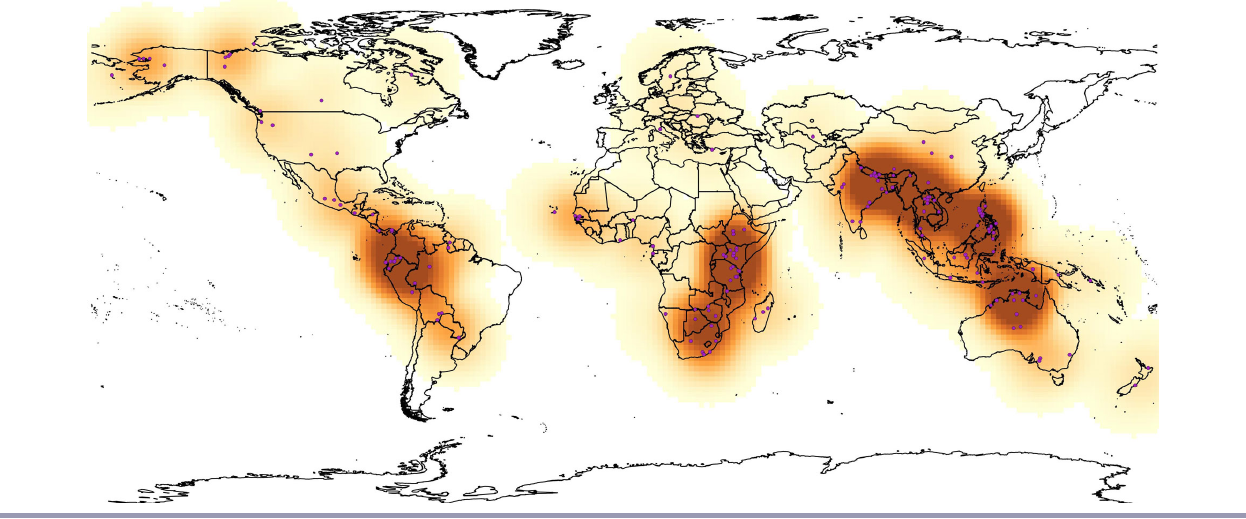
Fig. 1 . Distribution and kernel density estimation of case studies. The dots indicate the location of the case studies and the yellow color gradient represents the density of case studies in a given area.